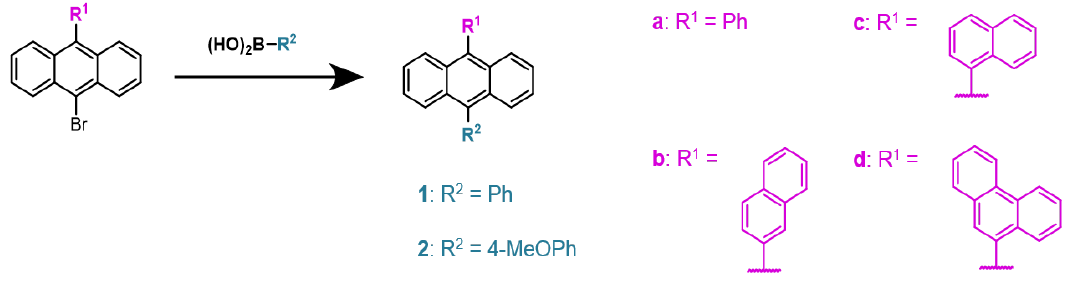
Figure 1. Synthesis of 9,10-disubstituted anthracenes (1a–c, 2a–d) via Suzuki-Miyura cross-coupling reactions.